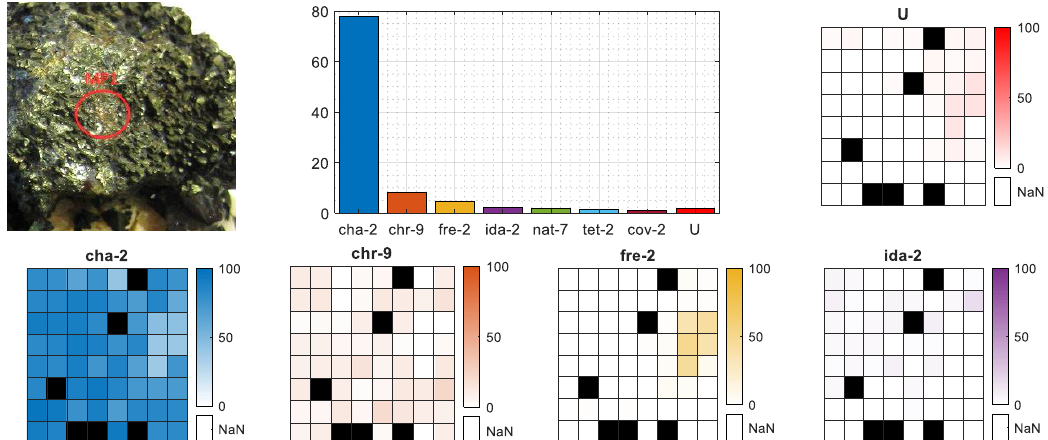
Figure 8. Mineral contribution for selected MP of chalcopyrite sample. Bar chart presents the total percentage rate of minerals per MP, the image indicates the place of measurement on the sample surface and the heatmaps present the geometrical distribution of the four main minerals and unknown class within 8 × 8 shooting grid. Black fields are missing spectra.